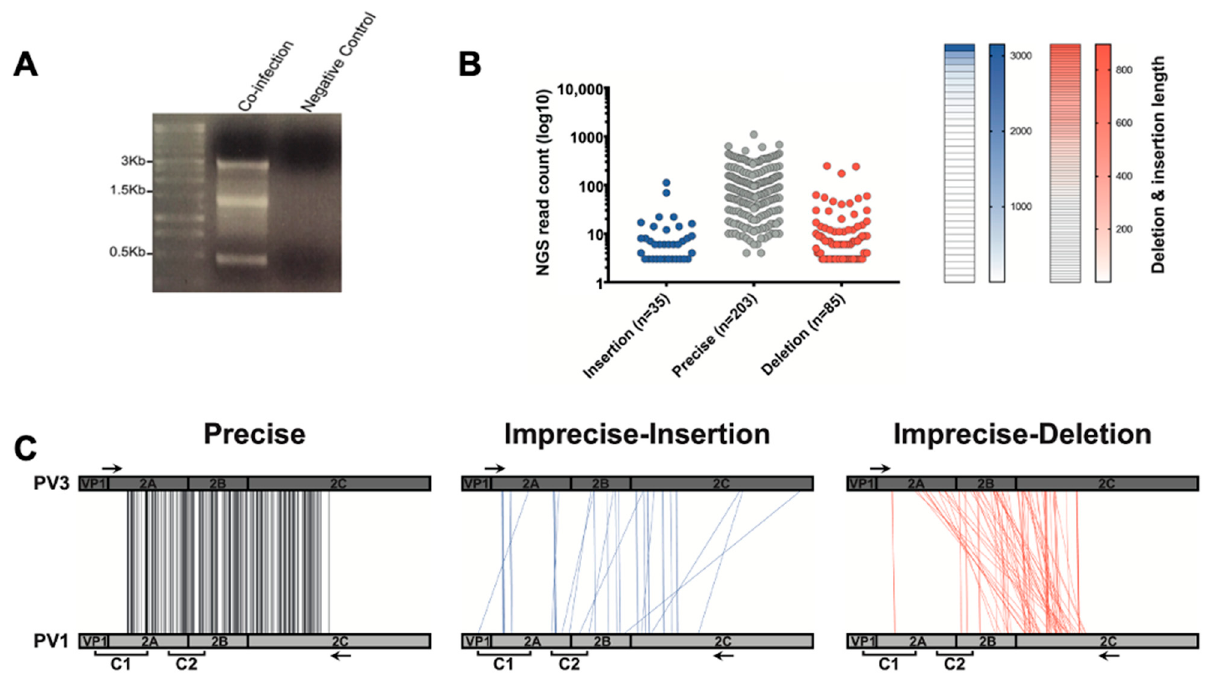
Figure 3. Isolation and characterization of recombinants generated from virus coinfection. ( A ) PCR amplification of the region between nucleotides 3235–4548 followed by agarose gel screening. The negative control is an equimolar mixture of in vitro transcribed full-length PV1 and PV3 RNA. ( B ) The number of precise and imprecise (both insertion and deletion) recombinants was plotted against the number of NGS reads (left panel); each dot represents a unique recombinant. On the right panel, heatmaps show the distribution of sequence lengths of insertion (blue) and deletion (red) within the detected imprecise recombinants. Each cell represents a unique recombinant. ( C ) Parallel coordi- nates visualization of recombinants from coinfection studies. The location of each recombination junction was mapped respective to each parental genome. Each line represents a unique recombi- nant within the population of precise (black), imprecise-insertion (blue), and imprecise-deletion (red) recombinants. Table 1. Number of NGS reads calculated for each sample using our